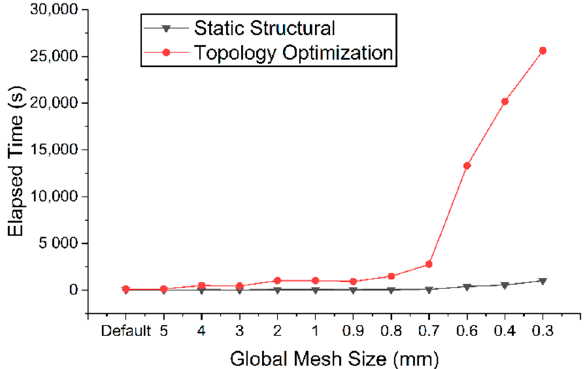
Figure 17. Elapsed time of simulation in different global mesh size.